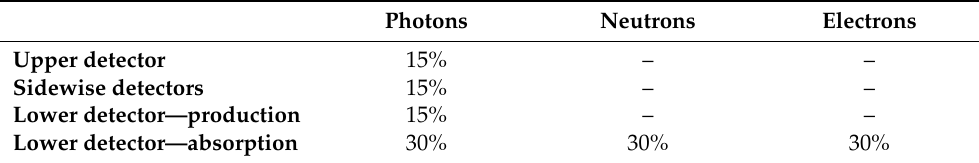
Table 4. The parameter set with the noise thresholds t min optimized for water.